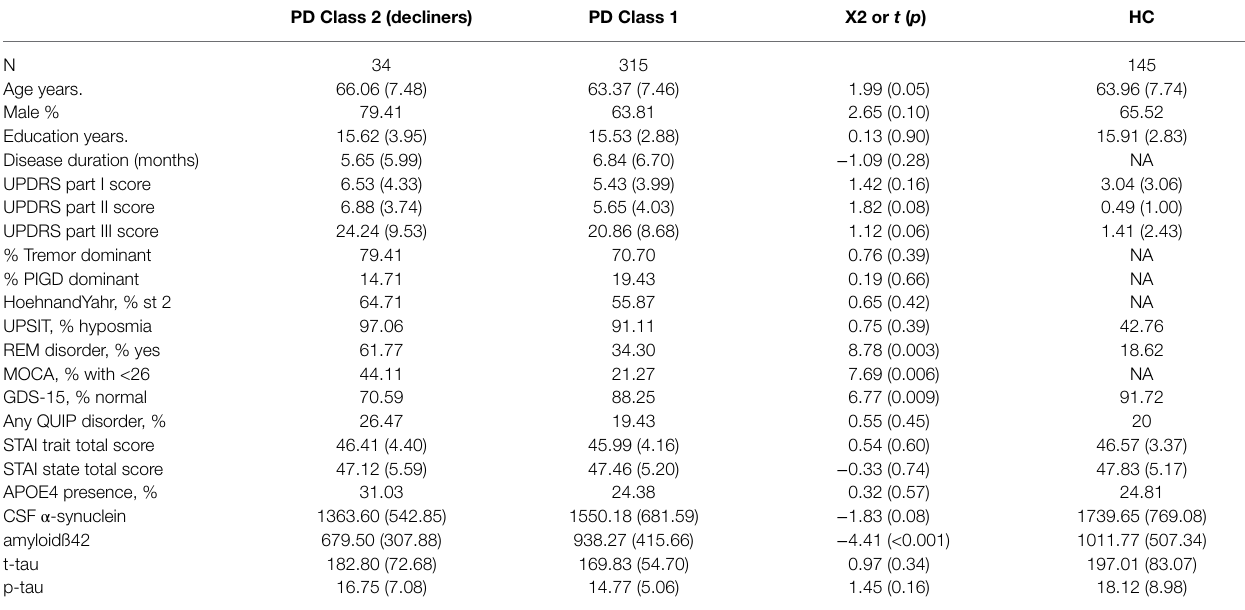
TABLE 3 | Baseline characteristics of PD patients by class and healthy